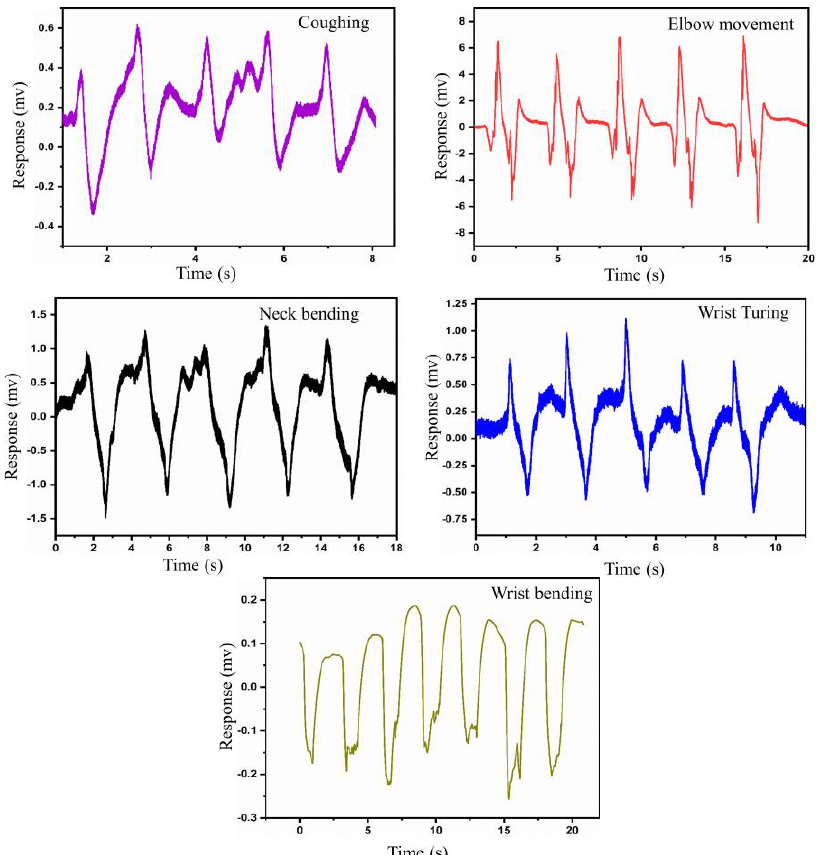
Figure 8. Signal recorded from various human gestures.